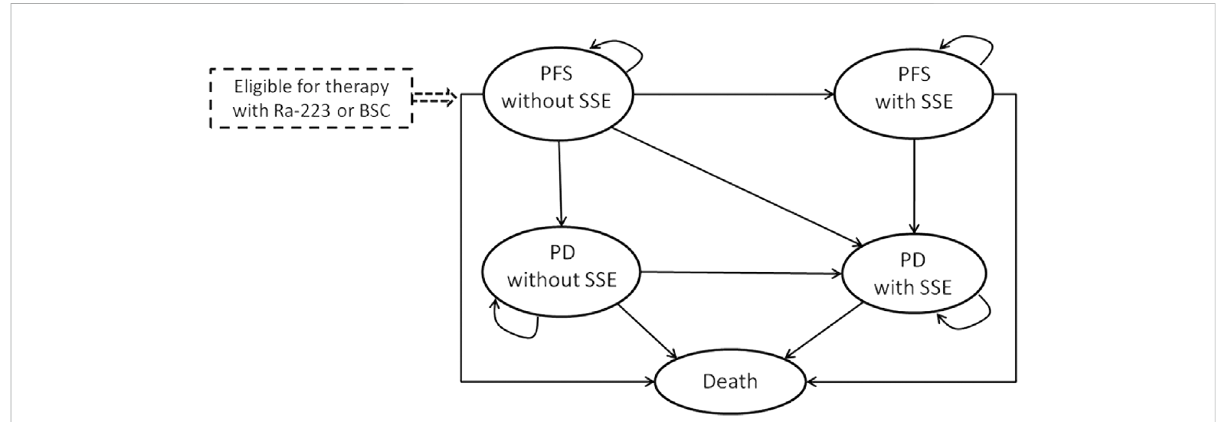
FIGURE 1 Markovmodelforpatientswithmetastaticcastration-resistantprostatecancer.PFS:progression-freesurvival;SSE:symptomaticskeletalevent; Ra-223: radium-223; PD: progression survival; BSC: best standard